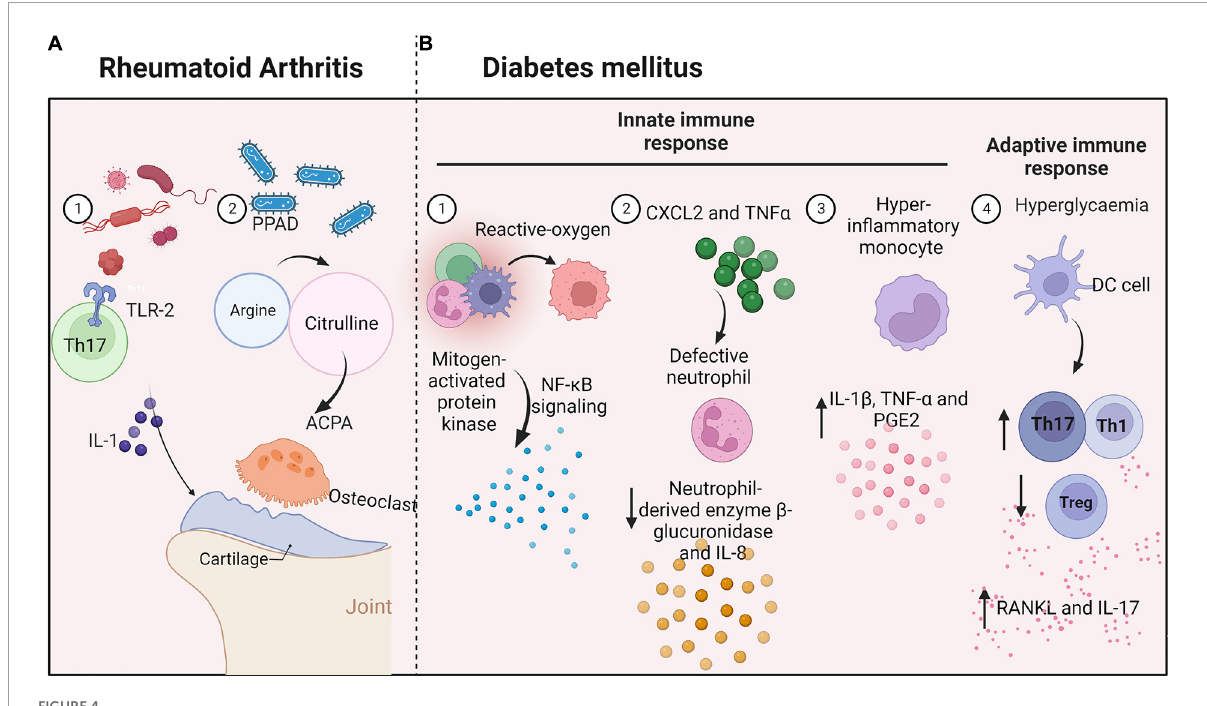
FIGURE4 Interconnections between oral microbes and immune cells in systemic diseases. (A) Rheumatoid arthritis: Periodontal pathogens induce a TLR-2 and IL-1-driven Th17 response and increase inflammatory cytokine levels in oral tissues, promoting bone erosion. (B) Diabetes mellitus: Hyperglycemia produces reactive oxygen species and causes defective neutrophils to increase β -glucuronidase and IL-8 secretion. Monocytes with a hyper-inflammatory phenotype produce IL-1 β , TNF- α , and PGE2. Moreover, high levels of glucose increase the generation of Th1 or Th17 lymphocytes and reduce the production of Treg